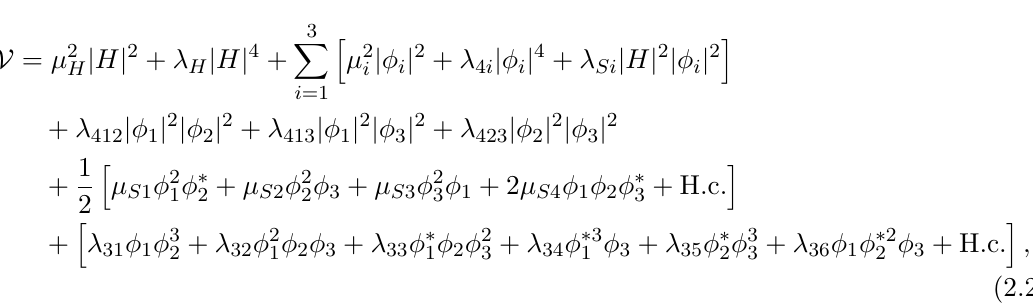
JHEP03(2023)100